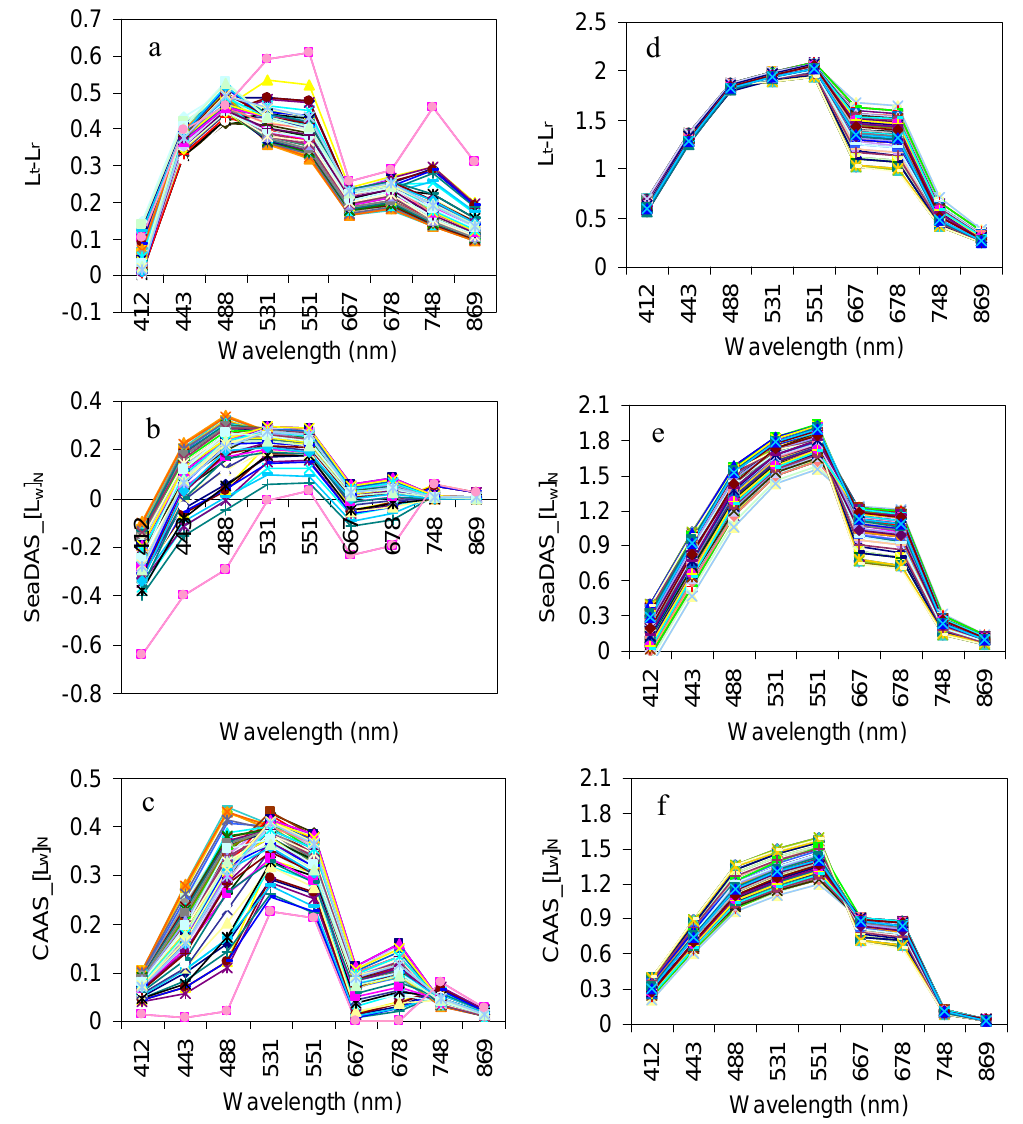
Fig. 4. Rayleigh-corrected (L t − L r ) and water-leaving radiance spectra [ L w ] N for intense algal bloom waters of the Arabian Sea (a) – (c) and turbid waters of the Korean Southwest Sea (d) – (f) , obtained from MODIS-Aqua imageries ( a – c : 18 February 2010; d – f : 4 December 2010) using the SeaDAS and CAAS algorithms. Locations are indicated in the corresponding MODIS-Aqua data (Figs. 2b and 3c).